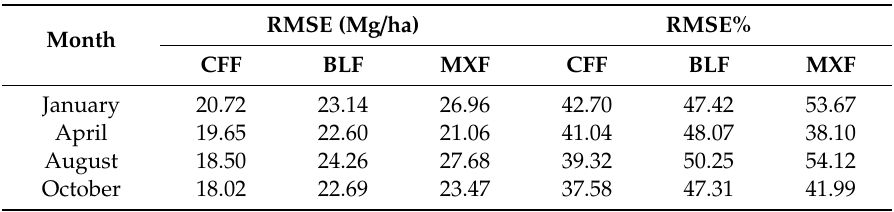
Table 6. Summary of RMSE (Mg / ha) and RMSE% results from di ff erent seasonal images under non-stratified